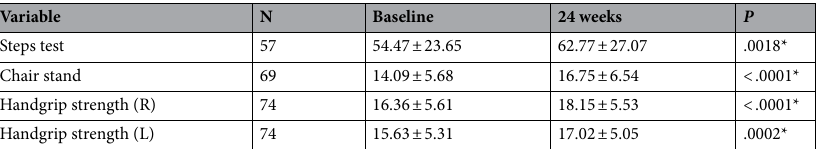
Table 5. Physical performance test: effect of the multi-domain intervention programme within the intervention group. Data presented in mean ± SD. P value indicates statistical difference within Intervention Group (IG).